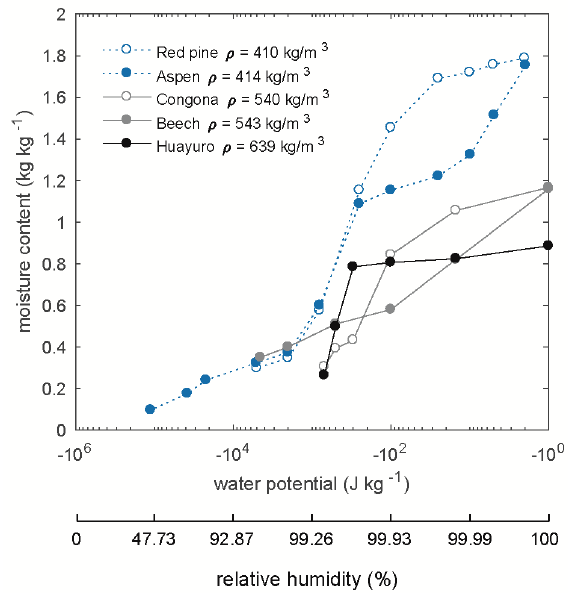
Figure 3. Over-hygroscopic desorption isotherms for wood of different densities. Data for red pine ( Pinus resinosa Ait.) [35] , aspen ( Populus tremuloides Michx.) [24] , congona ( Brosimum alicastrum Swartz) [33], beech ( Fagus grandifolia Ehrhart) [16], and huayuro ( Robinia coccinea Aublet) [33]. All densities, ρ (kg · m − 3 ), were defined as dry mass in relation to green volume. Note that the moisture content at water saturation is arbitrarily placed at − 10 ◦ J · kg − 1 .